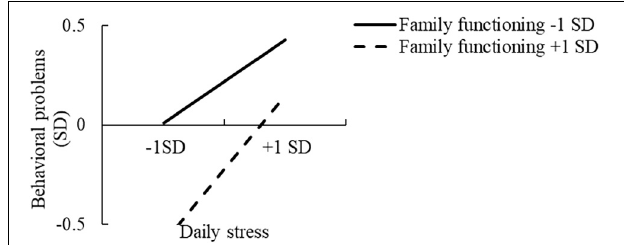
FIGURE 3 | Interaction between daily stress and family functioning, predicting children’s behavioral problems.